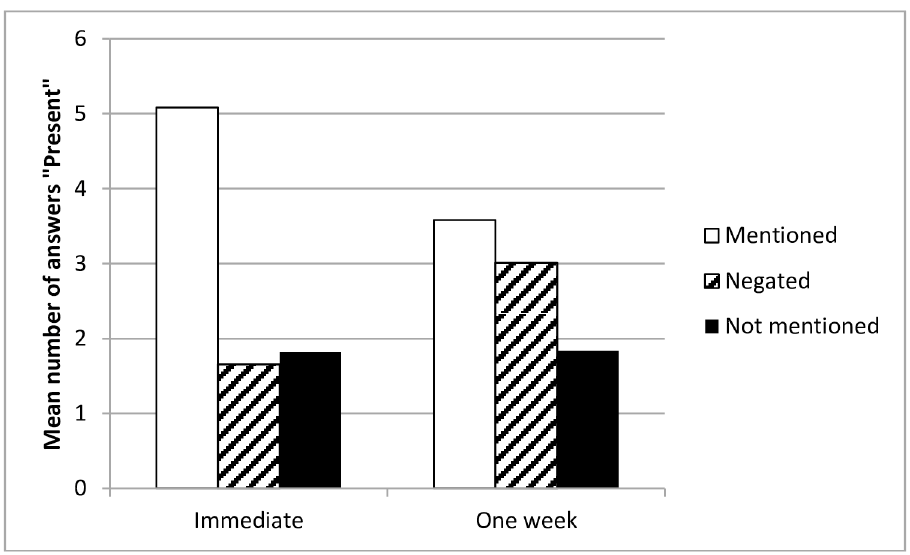
Fig 1. Mean number of ‘Present’ answers as a function of delay and type of information—Experiment 1.